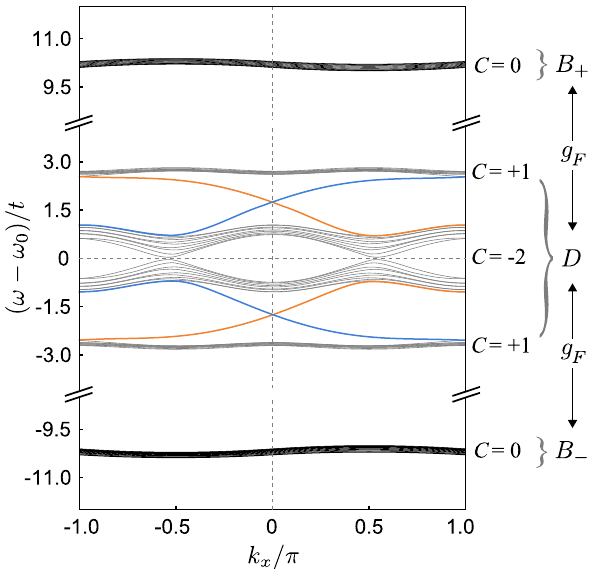
FIG. 4. Band structure of the microwave cavity implementation of the α ¼ 1 = 4 Hofstdater model in a strip geometry. The unit cell presented in Fig. 3(a) has three fundamental mode cavities, along with a single ferrite site, resulting in a total of six bands. When the ferrite energy is tuned large, two bright bands (black) are far separated from the four bands (gray) near ω 0 . These four bands have an edge state and Chern number structure consistent with the α ¼ 1 = 4 Hofstadter model. Here, blue (orange) lines connecting the bulk bands represent edge modes localized on the left (right) edge. No edge states connect the dark bands to the bright